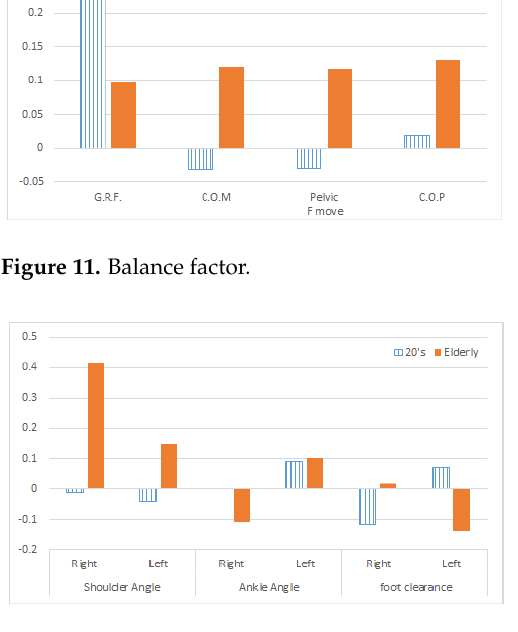
Figure 12. Angle factor.